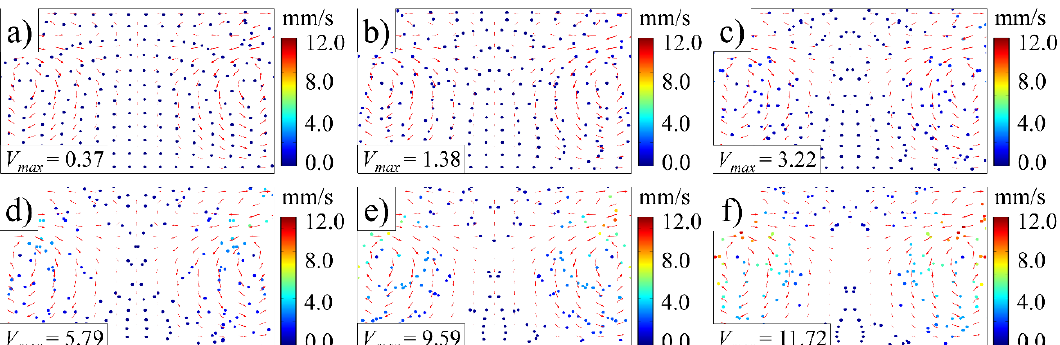
Figure 11. Trajectory of fluorescent particles at various ultrasonic amplitudes (ultrasonic frequency, 20 kHz): ( a ) 20 μm; ( b ) 40 μm; ( c ) 60 μm; ( d ) 80 μm; ( e ) 100 μm; ( f ) 120 μm.